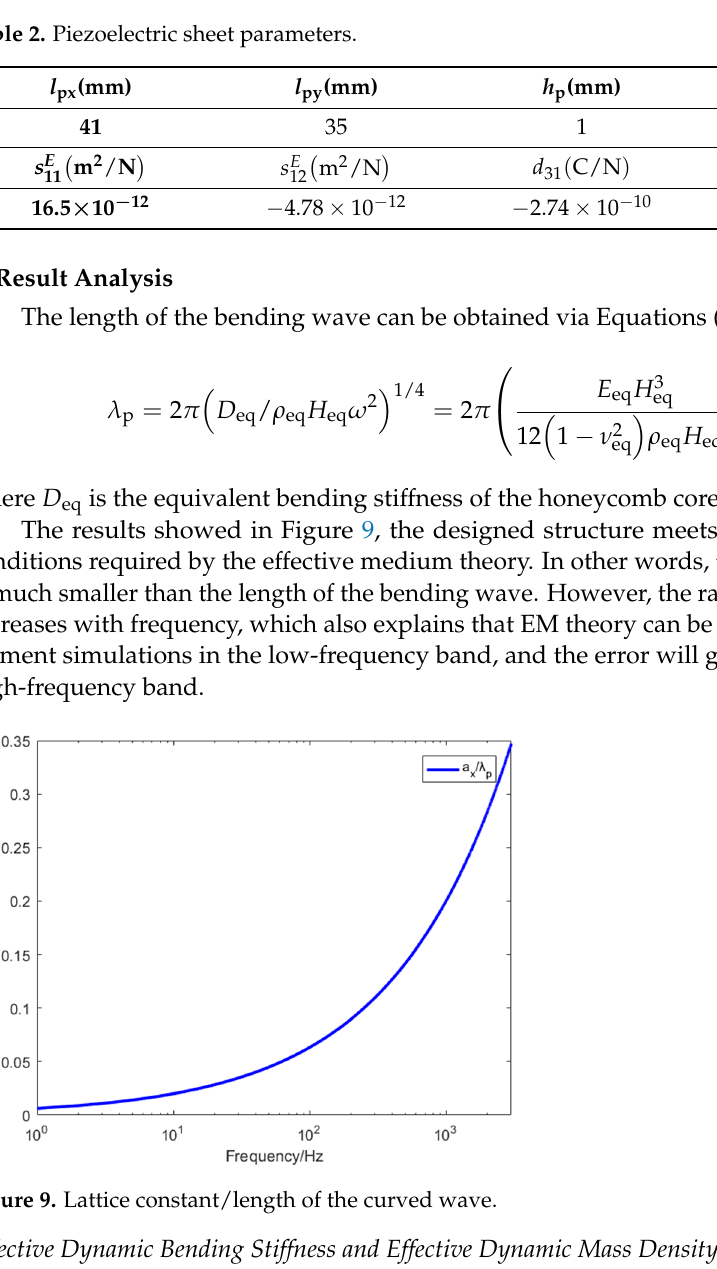
( b ) Figure 10. ( a ) Effective dynamic bending stiffness curve. ( b ) Voltage across the inductance.